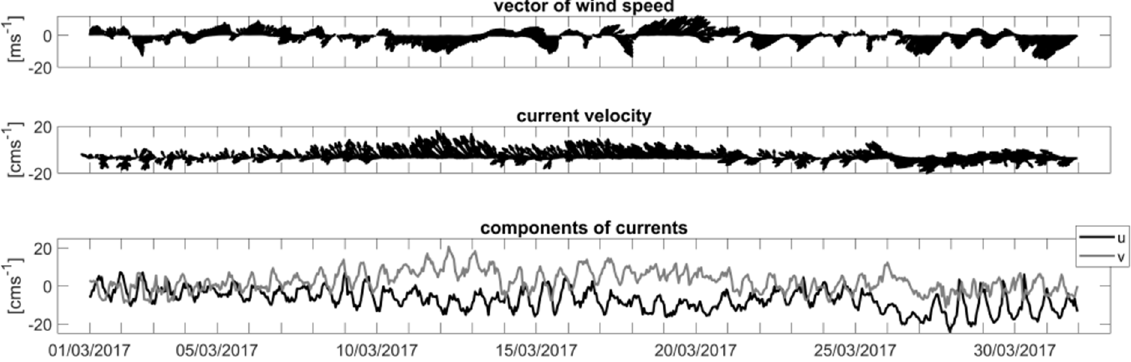
Figure A2. Top—wind speed U ( t ) vector plot from the ERA-5 meteorological reanalysis data. The second plot from the top is the current velocity u ( t ) at 100 m at ABS No. 1 in March 2017, and the third plot from the top shows the u - and v -components of the current velocity.